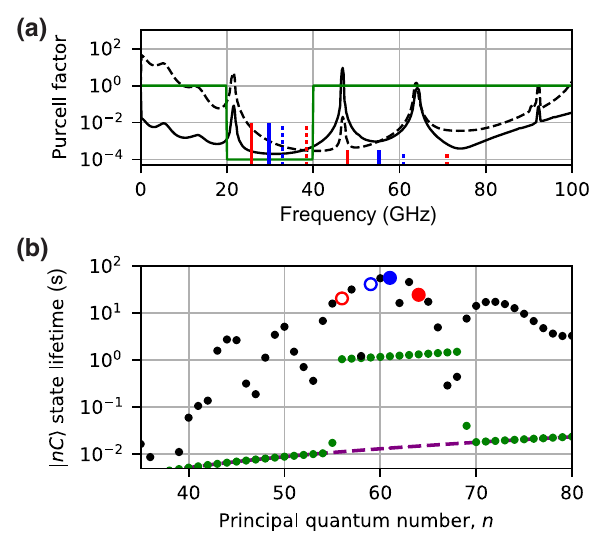
FIG. 2. Extending circular-state lifetimes. (a) LDOS suppres- sion (Purcell) factor inside the microwave waveguide. The black solid (dashed) line shows the simulated σ ± ( z )-polarized LDOS at the center of the structure, while the green line shows an idealized model for comparison. The long (short) lines show the frequencies of transitions between the n and n − 1 ( n + 2) manifolds for the four computational states. (b) Calcu- lated circular-Rydberg-state lifetime for the LDOS shown in (a) at an environment temperature T b = 4 K. For the full structure (black), the states used in the protocol are indicated using the colors used in Fig. 1(a). The dashed line shows the free-space lifetime at the same